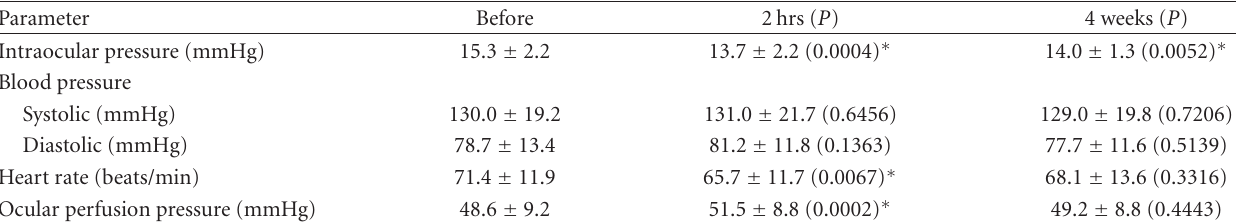
Table 3: Systemic and ocular parameters before and after topical application of nipradilol in normal-tension glaucoma.